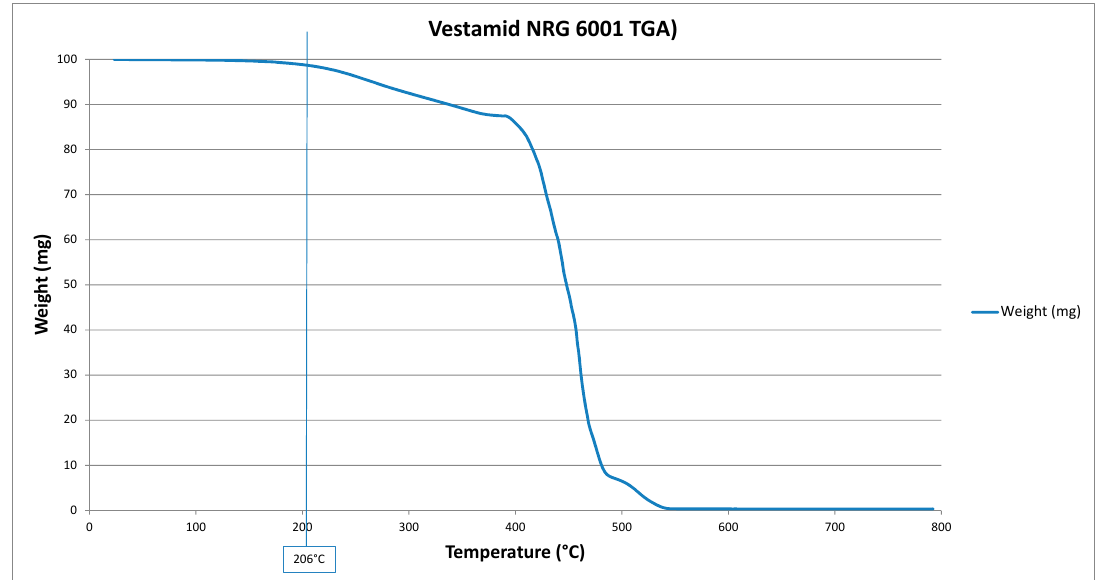
Figure 3. Thermogravimetric analysis of Vestamid NRG 6001.